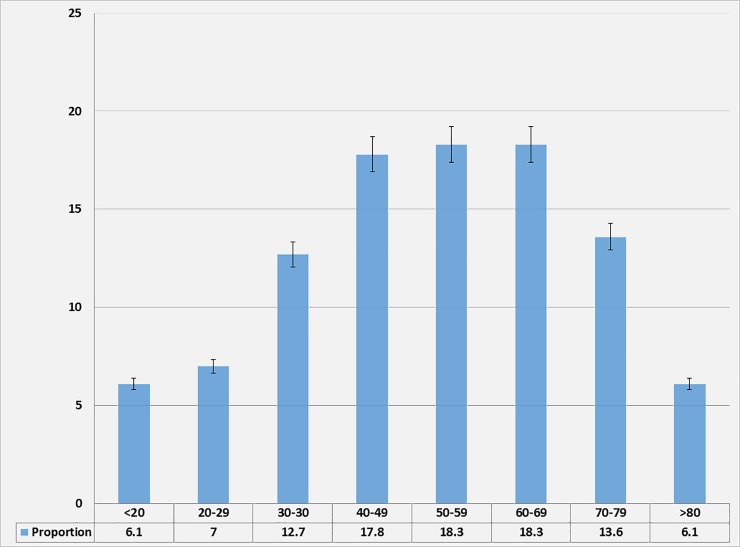
Age distribution of the study population.